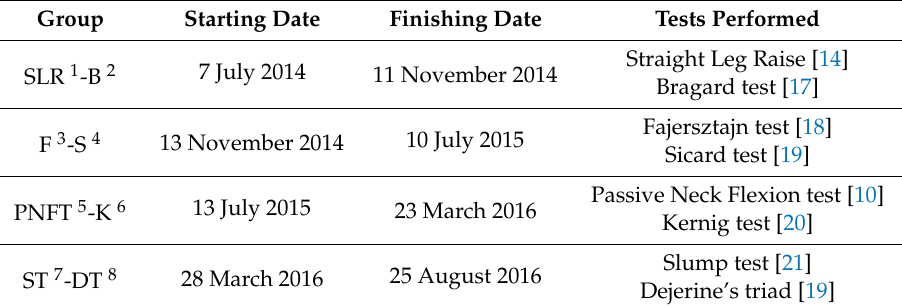
Table 1. Data collection of the